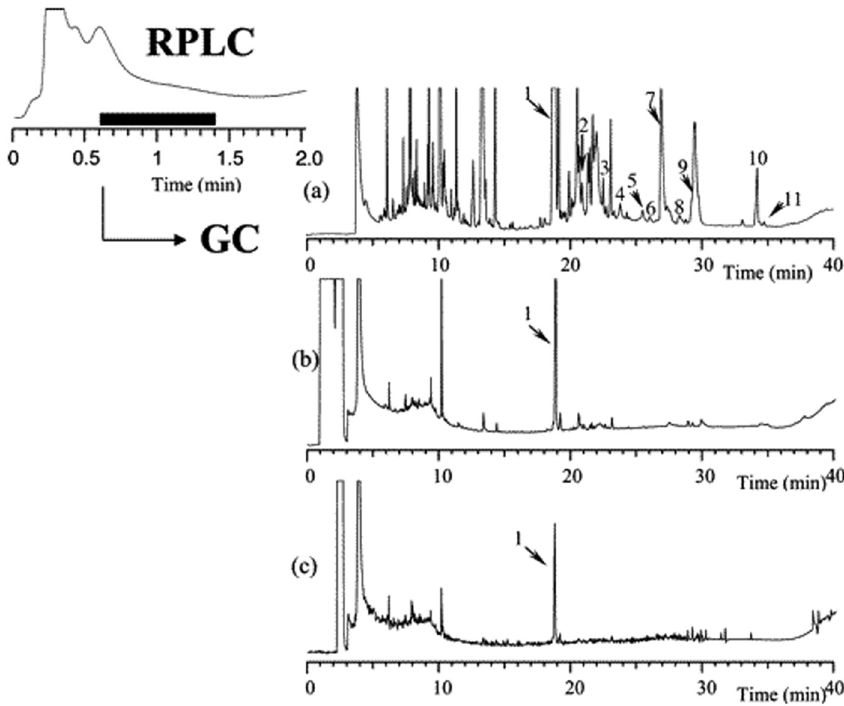
Figure 5: LC and GC chromatograms obtained in the online RPLC - GC - FID analysis of minor compounds ( free sterols, tocopherols, squalene, and erythrodiol and uvaol ) in a virgin olive oil using di ff erent transfer fl ows: ( a ) 0.1 mL min − 1 , ( b ) 1 mL min − 1 , and ( c ) 2 mL min − 1 . The thick line in the LC chromatogram indicates the LC fraction transferred from the liquid chromatograph to the gas chromatograph. Reprinted with permission from ref. [ 58 ] . Copyright 2020 American Chemical